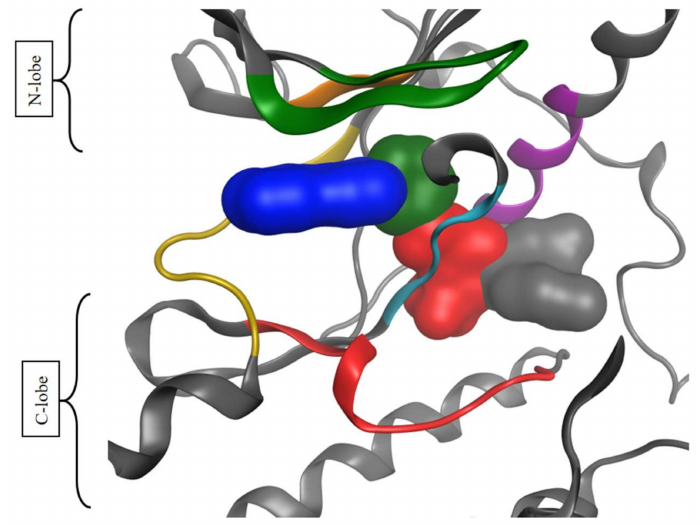
Figure 2. Representation of the different binding pockets targeted by kinase inhibitors. Blue, adenine binding site; green, hydrophobic pocket; red, allosteric pocket; and grey, adjacent allosteric pocket. The backbone of VEGFR2 (PDB ID 4ASD) is colored according to the following colors: yellow, hinge region; cyan, DFG motif; green, P-loop; purple, α C-helix; red, catalytic subunit; and orange, VAIK catalytic